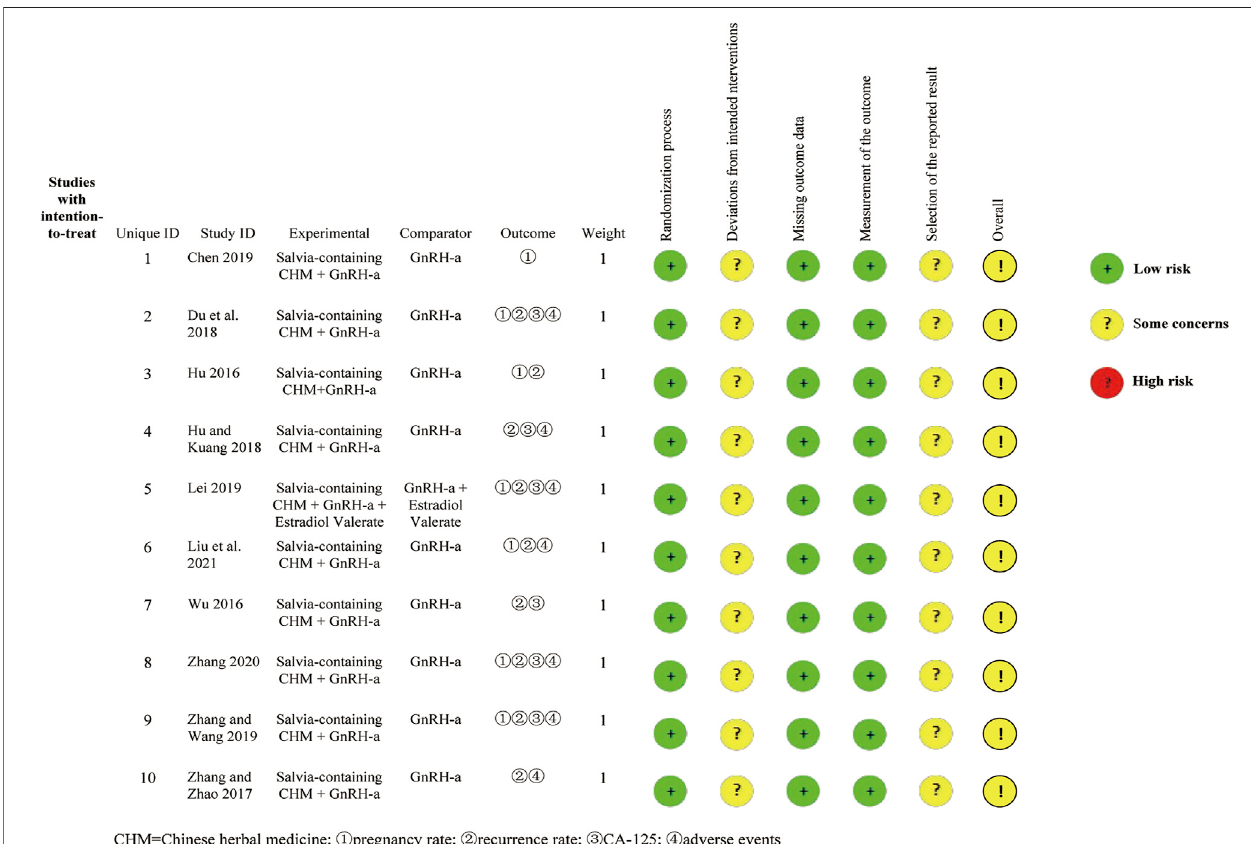
FIGURE 2 | Risk of bias